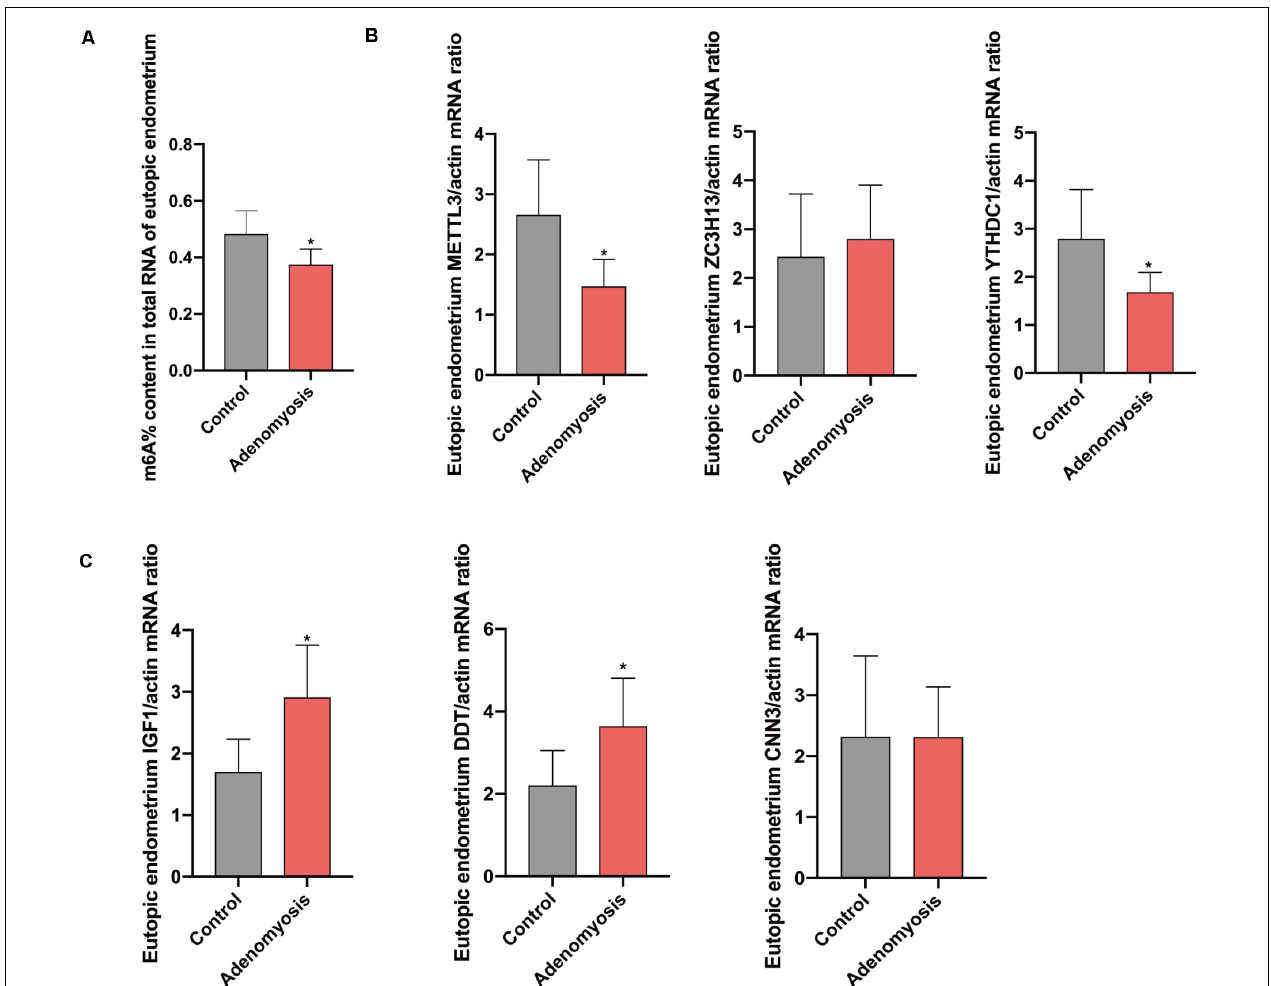
FIGURE 4 | The total m 6 A level and qRT-PCR validation of bioinformatics data in eutopic endometrium of women with and without adenomyosis. (A) m 6 A% content in total RNA in the eutopic endometrium of women with and without adenomyosis. (B) The expression of METTL3 , ZC3H13 , YTHDC1 mRNA level in the eutopic endometrium. (C) The expression of IGF1, DDT , and CNN3 mRNA level in the eutopic endometrium. n = 6 for each group. * p <